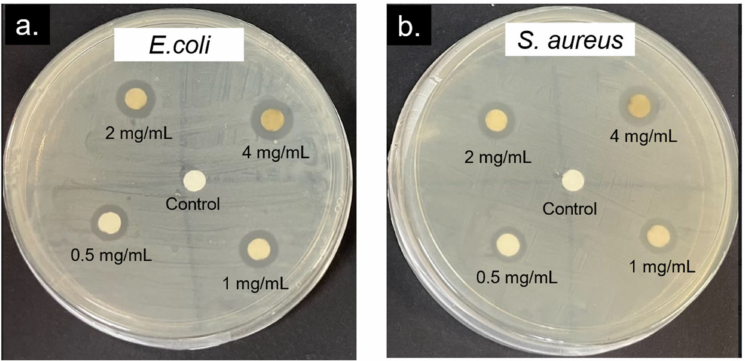
Figure 8. Representative agar plates of the disk diffusion assay of c-AgNPs with the concentration of 0.5–4 mg/mL against ( a ) E. coli and ( b ) S. aureus . Table 1. Zone of inhibition expressed in mm measured from the disk diffusion